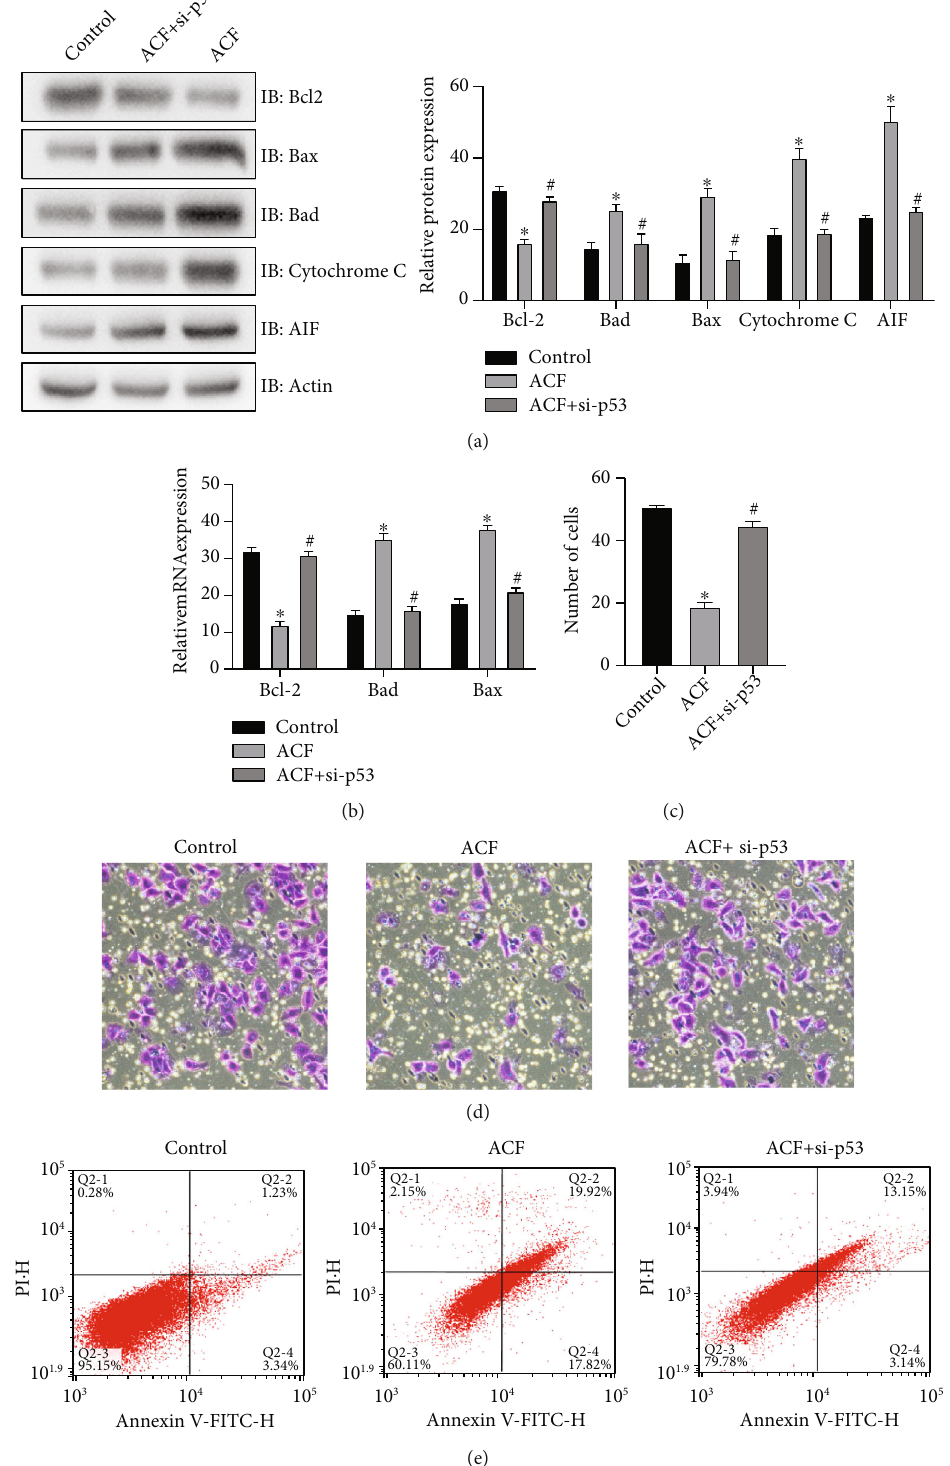
Figure 4: Inhibition of p53 expression, the regulatory e ff ect of ACF on SW620 cells was partially relieved. (a) Western blot results showed that after p53 deletion, the expression level of Bcl-2 increased, while the expressions of Bad, Bax, AIF, and cytochrome C decreased. (b) The experimental results of QRT-PCR showed that the regulation of Bcl-2, Bad, Bax, AIF, and cytochrome C was partially relieved by ACF after p53 was knocked down. (c) MTT test results showed that cell proliferation increased after p53 deletion. (d) The results of in vitro invasion experiment showed that the invasion ability of cells recovered after p53 deletion. (e) Flow cytometry results showed that the apoptosis ability of cells was weakened after p53 deletion. ∗ P < 0 : 15 , compare with the control group. # P < 0 : 15 , compare with the ACF + si − p53